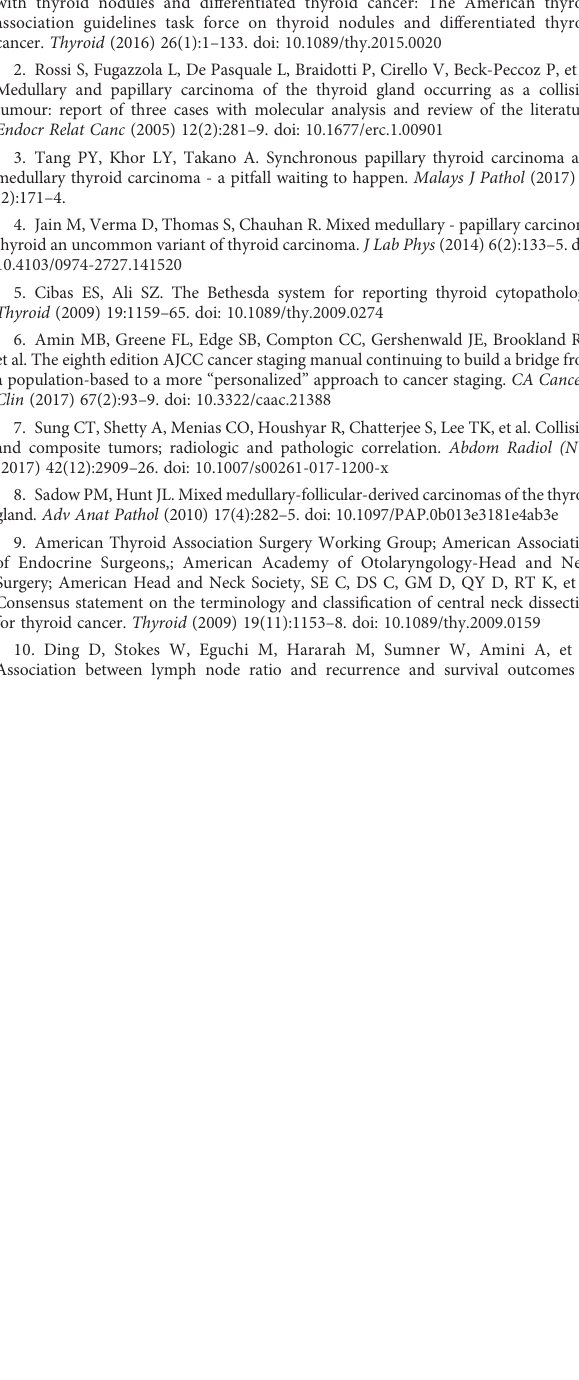
SUPPLEMENTARY FIGURE 1 Immunohistochemistryofpatientn.6thatMTCandPTCwerelocatedclosely. A:CgA(+); (B) CgA(+); (C) CT(+); (D) Syn(+); (E) Tg(-); (F) TTF-1(+). SUPPLEMENTARY FIGURE 2 Immunohistochemistry of patient n.17 that MTC and PTC were located in the different tumor of ipsilateral lobe. A:Ck19(+); (B) CT(+); (C) TTF-1(+); (D) Ggh(+).